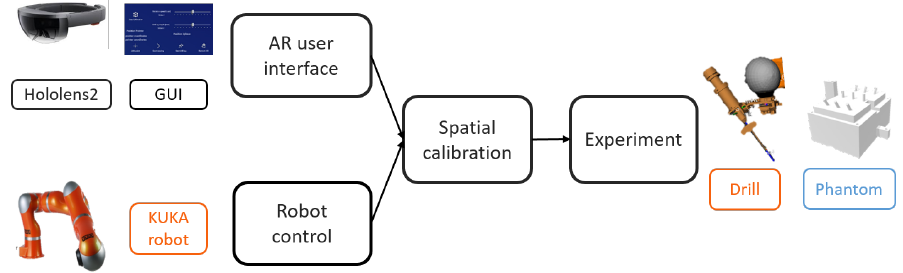
Figure 1. The framework for the proposed system, including the main steps: AR user interface, robot control, spatial calibration, and experiments on the phantom.